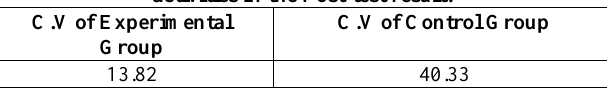
Table No.4.5 indicates the mean scores of control and Table No 4.7: The Co-efficient of Variance (C.V) classroom